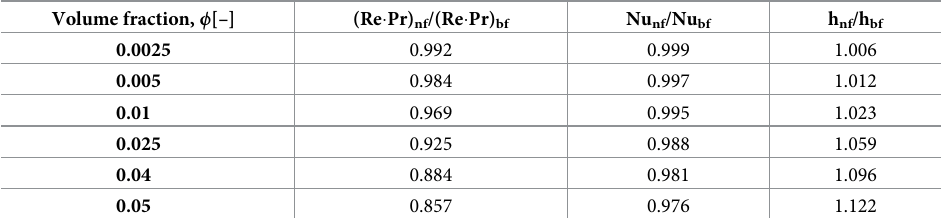
Table 4. (Re � Pr), Nu and heat transfer ratios at 0.24 l/min. Volume fraction, ϕ